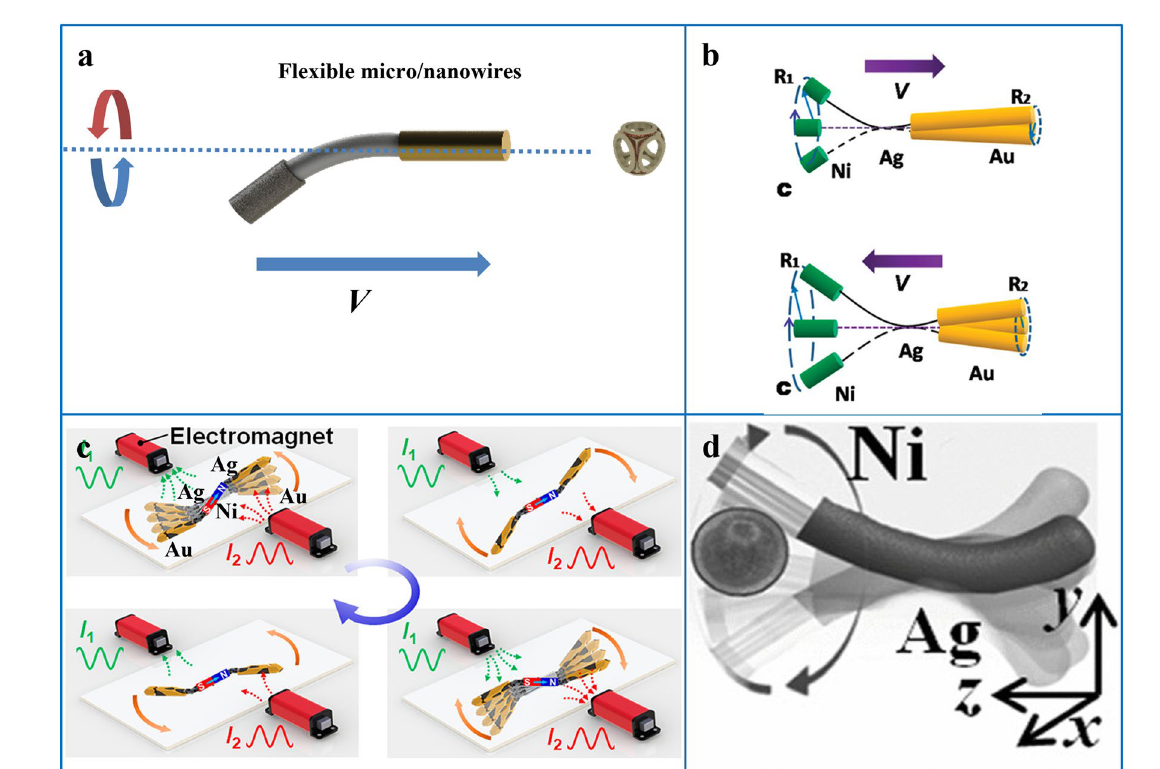
Fig. 8 a Schematic diagram of a flexible nanowire driven in a magnetic field. b Schematic diagram of the motion of the Au/Ag/Ni flex- ible nanomotor in a rotating magnetic field. Reprinted with permission from Ref. [43]. Copyright (2010) American Chemical Society. c Sche- matic diagram of the motion of the Au/Ag/Ni/Ag/Au flexible nanomotor in an oscillating magnetic field generated by a pair of electromag- nets. Reprinted with permission from Ref. [137]. Copyright (2021) American Chemical Society. d Schematic illustration of the Ni/Ag flexible nanomotor moving and drug loading in a rotating magnetic field. Reproduced with permission from Ref. [162]. Copyright (2012) John Wiley &